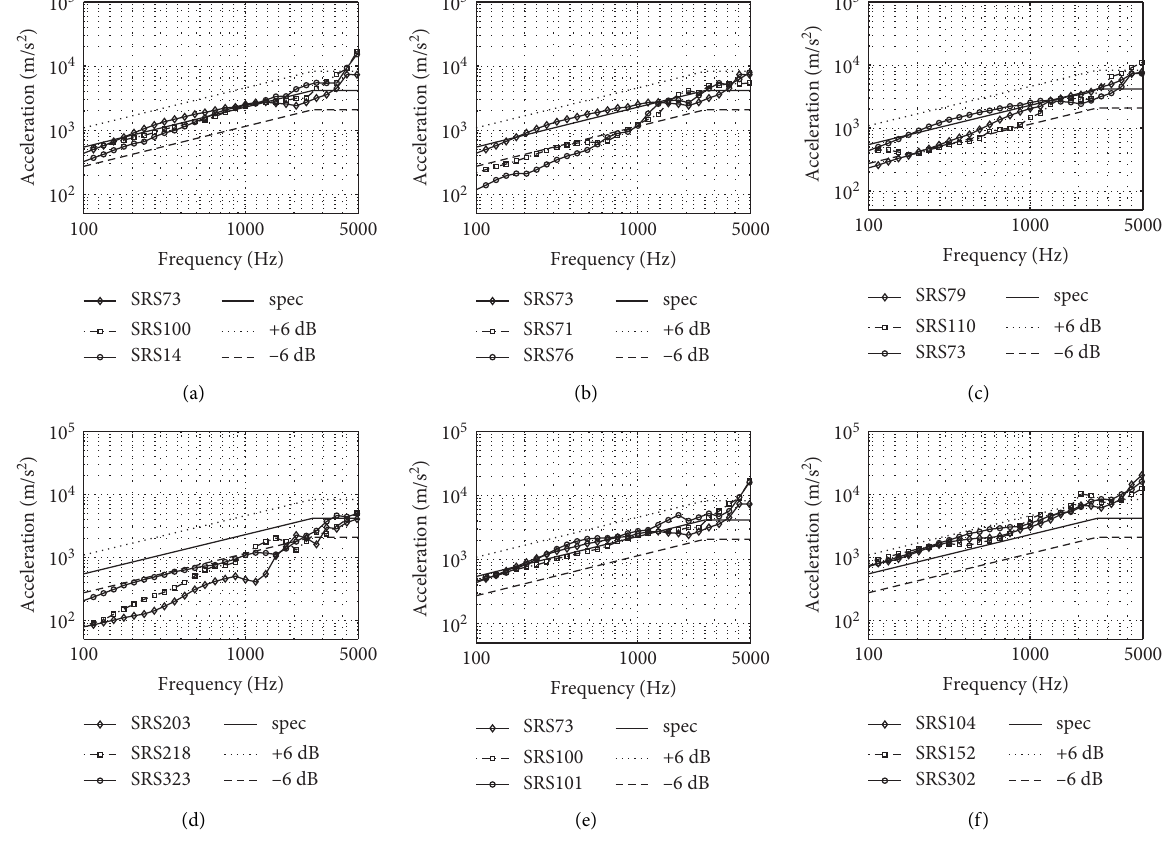
Figure 5: Comparing the three most similar SRS to a target SRS spec using different similarity metrics (database size � 324 channels). (a) MAD, (b) ASR, (c) E R , (d) M R , (e) RMSE, and (f) Δ j